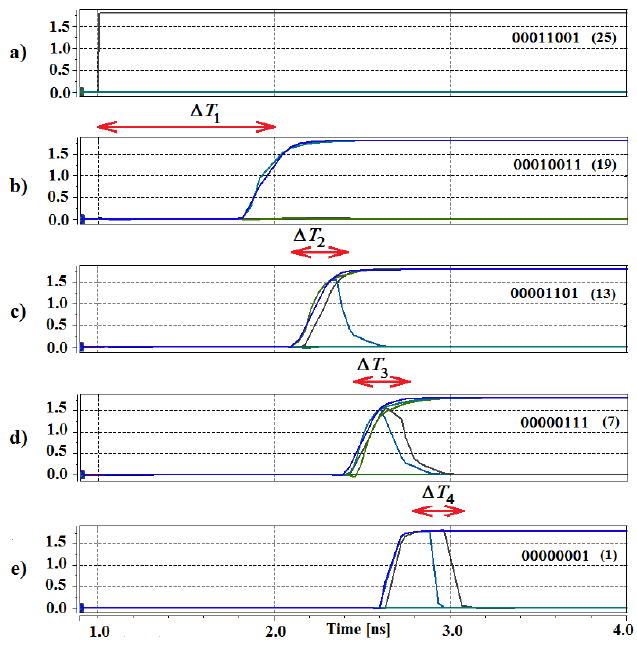
Figure 12. Selected simulation results illustrating the β k signals at following rings of neurons.